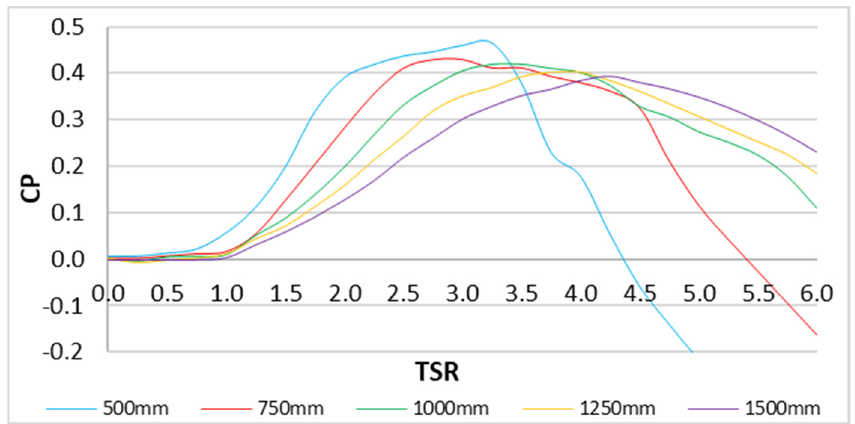
Figure 8. Coefficient of power vs. TSR plot for different turbine radii.